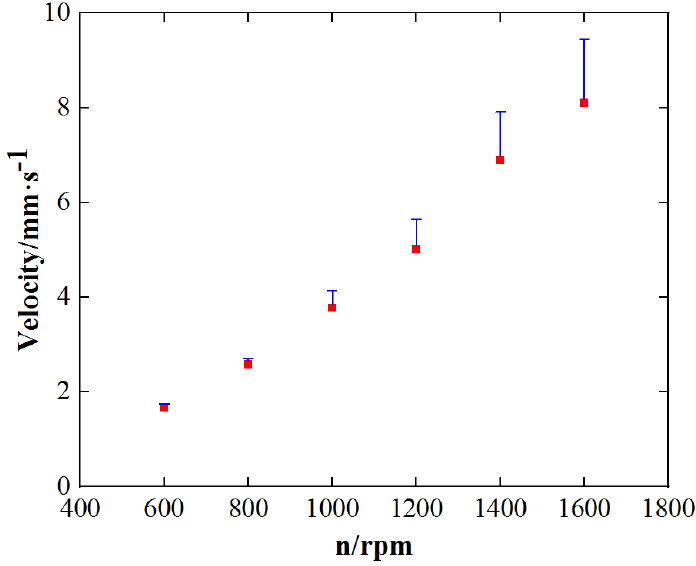
Figure 8. The average velocity and the average absolute error of instantaneous velocity as a function of the rotation speed ( D = 0.3 mm, μ o = 12.60 mPa s, a = 1.061 mm/rad).